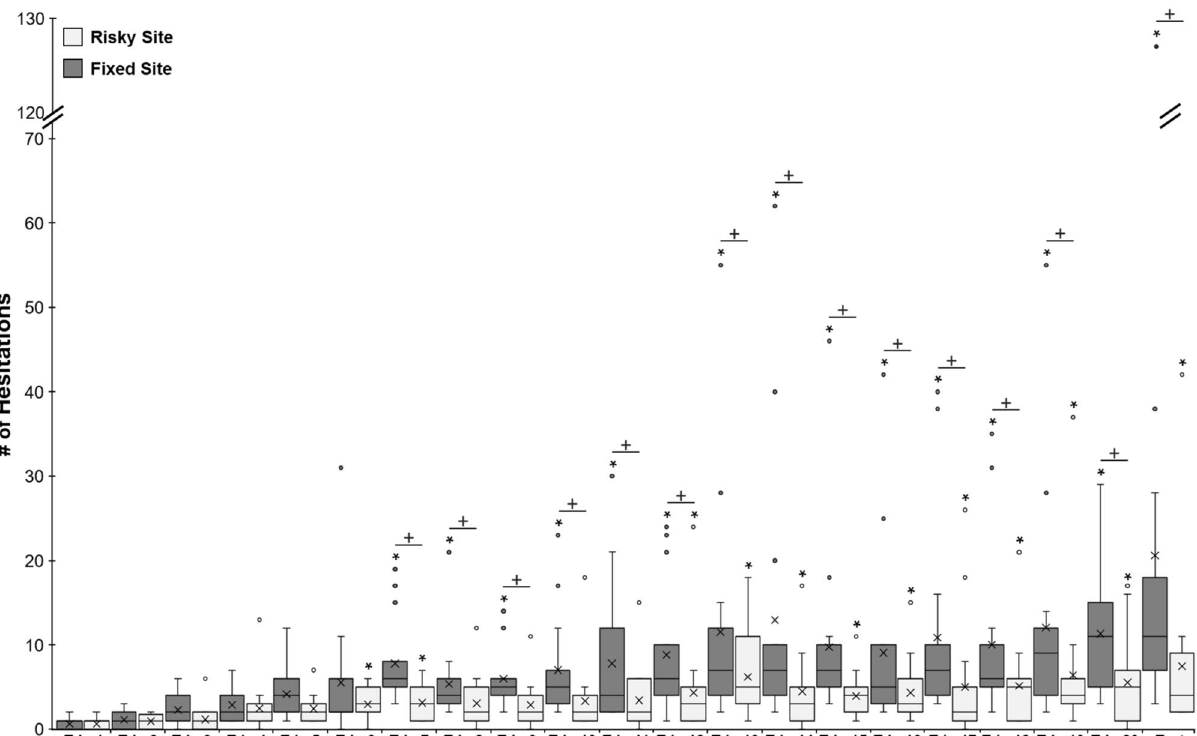
Figure 7. Forager hesitations during training Trips 1–20 and one zero vector test in the Risk sensitivity tests. During training, foragers were collected at both Site 1 and Site 2 and held within a vegetation-filled container for either a fixed or risky period. At the fixed site, foragers were held for 150 s, while at the risky site foragers had a 50/50 chance of being held for 1 s or 300 s. After the hold period, foragers were allowed to climb out of the container and return with their food to the nest. After training Trip 20, foragers were collected at the nest and tested as ‘zero vector’ foragers, by placing them back onto the route at 10 m from the nest. During the test, released foragers were allowed to travel through Site 1 and Site 2 without collection. Box plots show the median hesitations, consisting of scans and stops, across training and testing (middle line), mean hesitations (×) and 25th and 75th percentile (box) while the whiskers extend to min and max values (excluding outliers). Outliers were defined as values 150% of the IQR beyond 25th and 75th percentile and represented as individual points. Each *Denotes training or test trips where forager hesitation numbers were significantly above the Trip 1 baseline (p < 0.05). Each ‘+’ denotes trips in which the forager showed significantly higher hesitation numbers leading up to the fixed (150 s) collection site compared to the risky (1 s/300 s) site (p < 0.05). For heat maps of hesitations for all training and test trips in the Risky Perception tests, see SFigs. 4 and